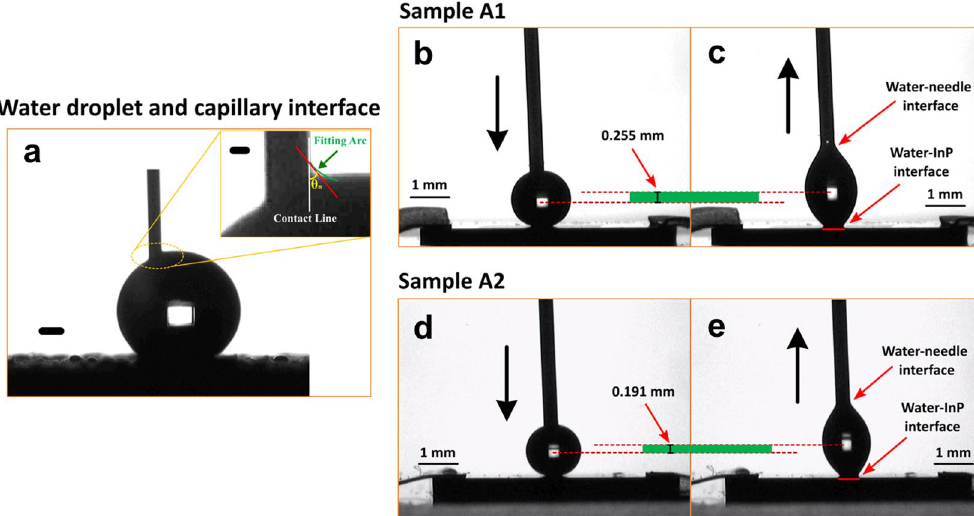
Figure 4. Estimation of adhesion energies among the interfaces of water droplet, dispensing needle and re- entrant structure surfaces. Interface between the water droplet and the capillary needle. ( a ) The syringe needle was inserted into a water droplet that was supported by a hydrophobic surface (Bars: 1 mm; insert, 100 μ m). The contact angle of the needle surface was measured through fitting an arc of the meniscus of water and then fitting a tangent line at the intersection of the water-needle contact line and the fitted arc, the angle θ n between the contact line and the tangent line is the contact angle of the needle surface. Water droplet contacting and leaving the surface of the Sample A1. ( b ) The needle was lowered to allow the water droplet contact the substrate. ( c ) The needle was raised and tended to remove the water droplet from the substrate. It showed a hysteresis due to the hydrophilicity of the InP surface. The red line at the water-InP interface shows the diameter of the contact area when the droplet was about to leave ( D s1 = 0.486 mm). Comparing b and c, the barycentre of the water droplet rose by 0.255 mm. Water droplet contacting and leaving the surface of the Sample A2. ( d ) The needle was lowered to allow the water droplet contact the substrate. ( e ) The needle was raised and tended to remove the water droplet from the substrate. It showed a hysteresis due to the hydrophilicity of the InP surface. The red line at the water-InP interface shows the diameter of the contact area when the droplet was about to leave ( D s2 = 0.467 mm). Comparing d and e, the barycentre of the water droplet rose by 0.191